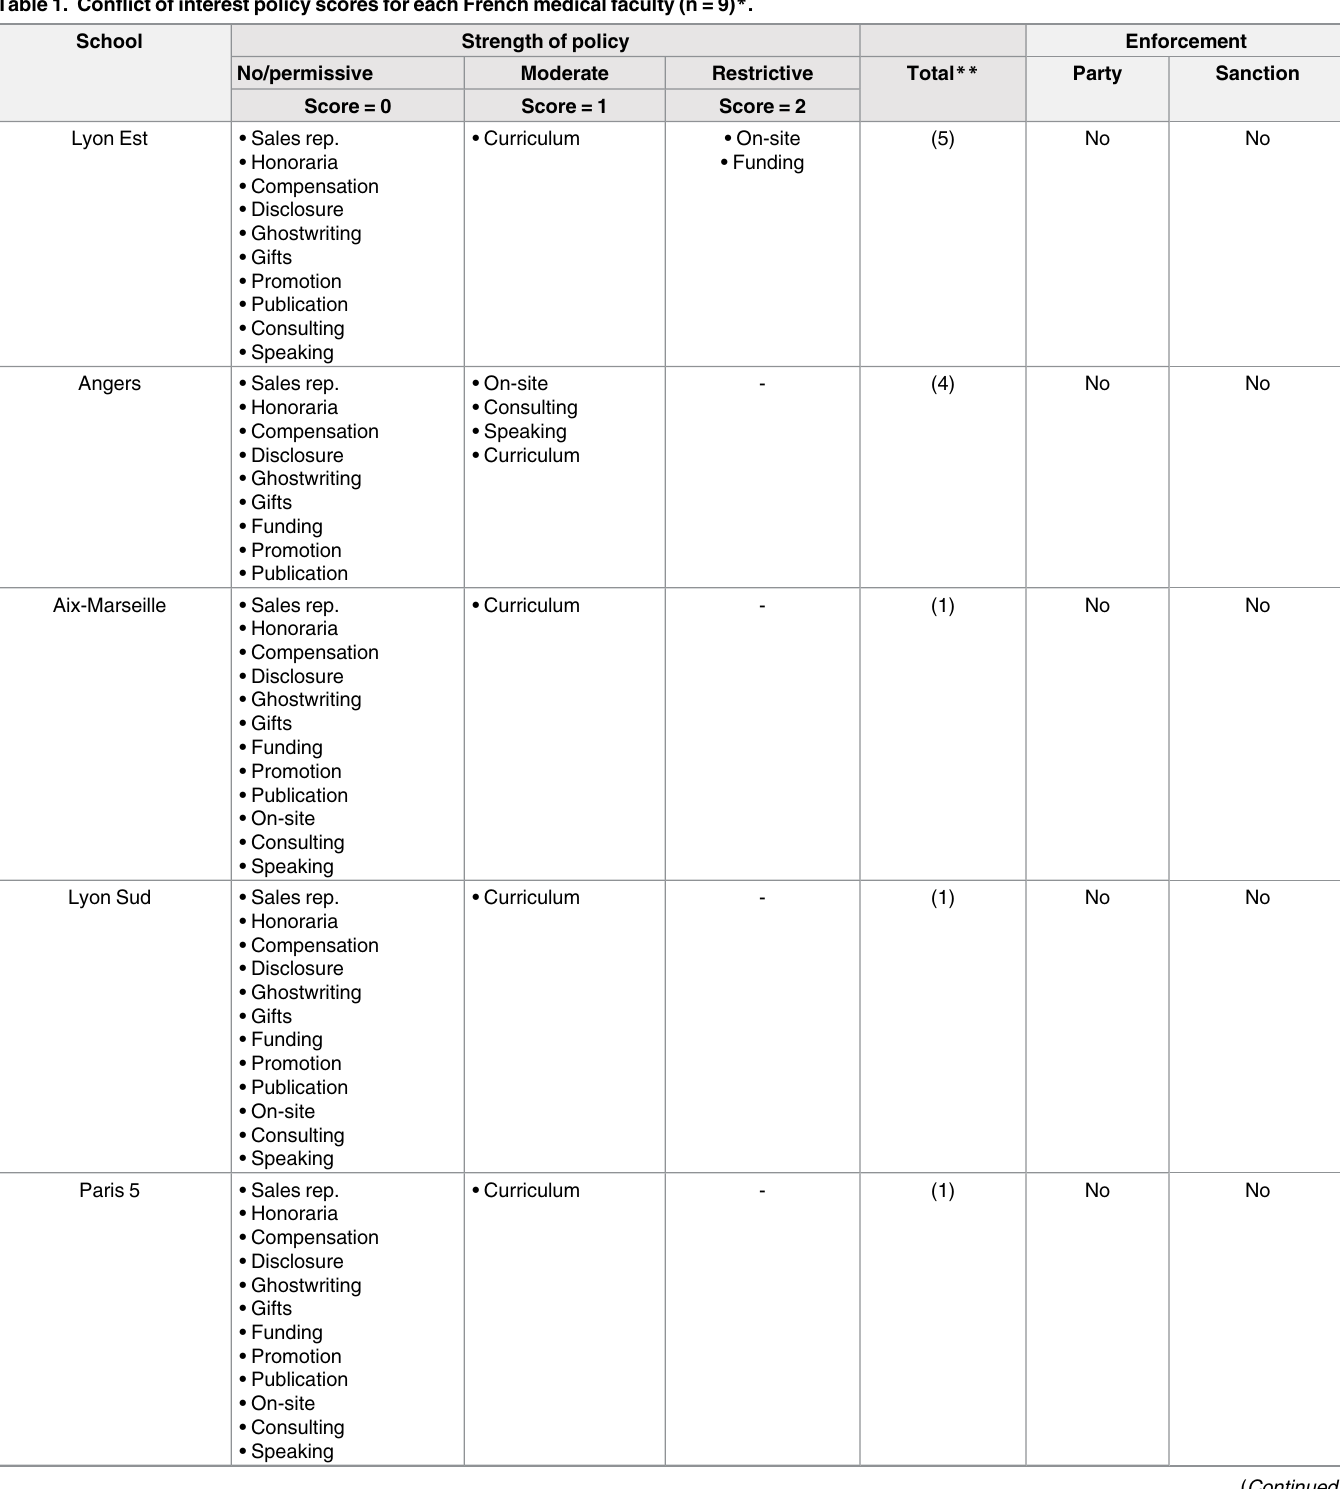
Table 1. Conflict of interest policy scores for each French medical faculty (n = 9) * .